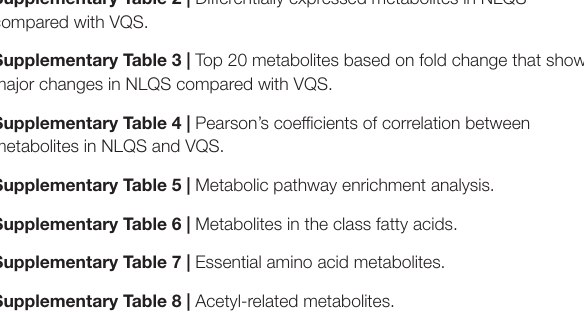
Supplementary Table 1 | Statistics of the number of peaks. Supplementary Table 2 | Differentially expressed metabolites in NLQS compared with VQS.